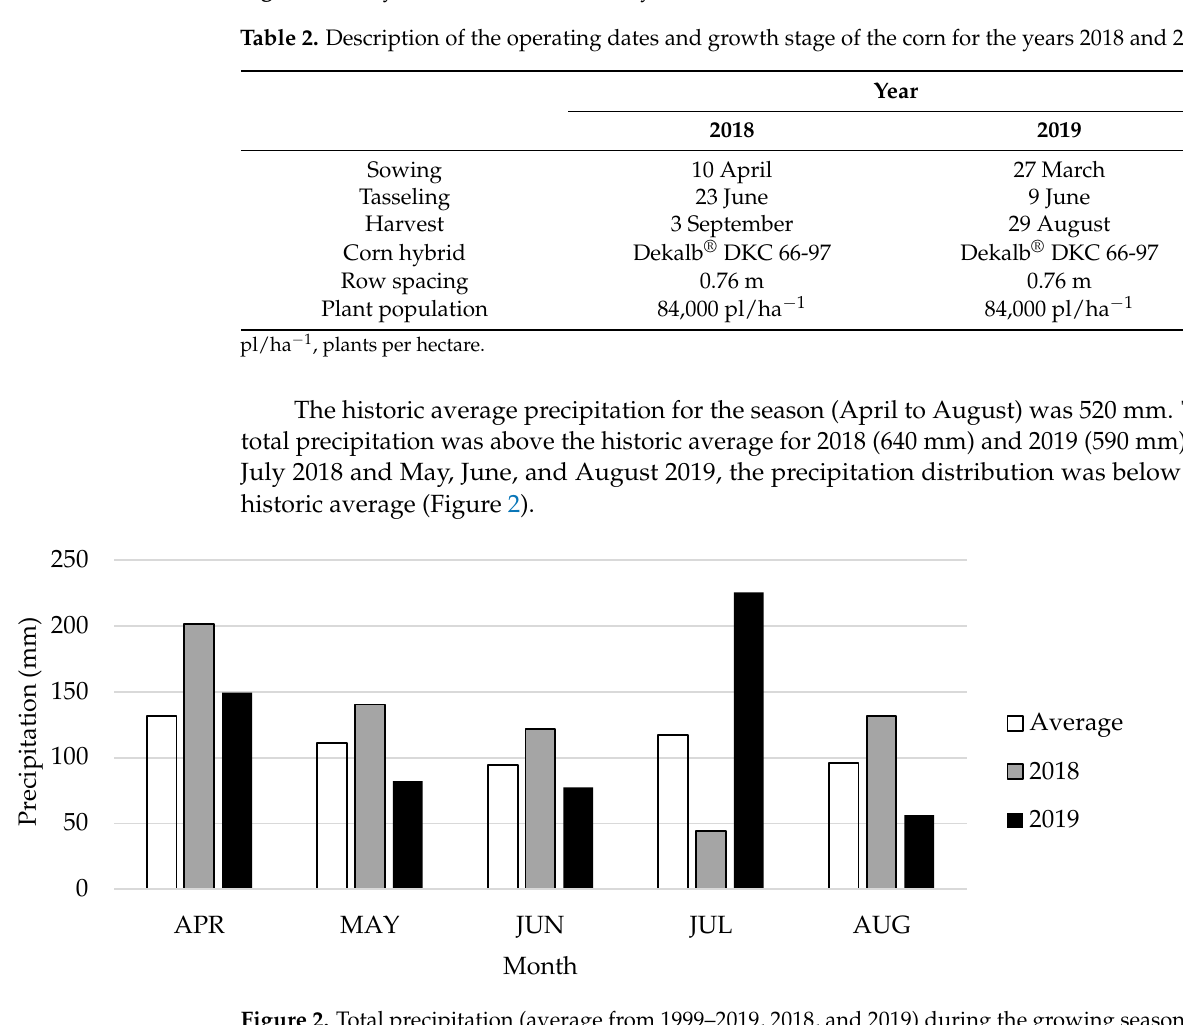
Figure 1. Study field in Lawrence County, Alabama, US. Table 2. Description of the operating dates and growth stage of the corn for the years 2018 and 2019.